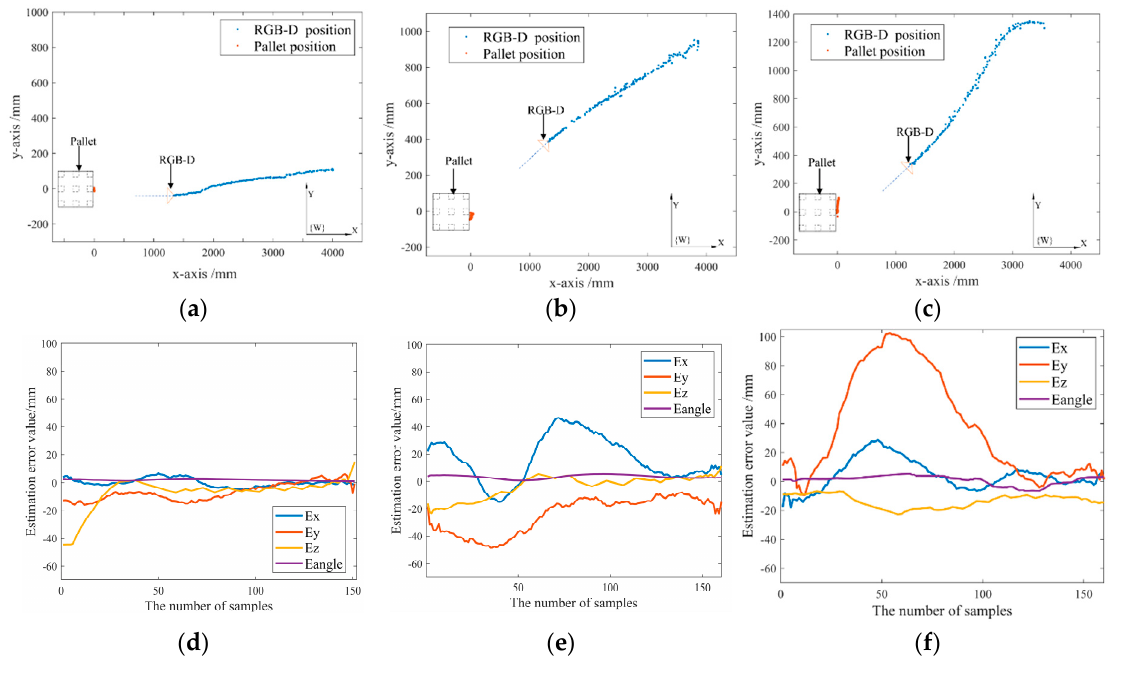
Figure 10. Verification of the algorithm’s performance in measuring accuracy when the angle dynamics change. ( a ) Sensor position as well as pallet positioning results data in the sensor angle range of 0 − 10° during sensor approach. ( b ) Sensor position as well as pallet positioning results data in the sensor angle range of 10 − 20° during sensor approach. ( c ) Sensor position as well as pallet positioning results data in the sensor angle range of 0 − 40° during sensor approach. ( d ) Error of pallet positioning results corresponding to Figure 9a. ( e ) Error of pallet positioning results corresponding to Figure 9b. ( f ) Error of pallet positioning results corresponding to Figure 9c.